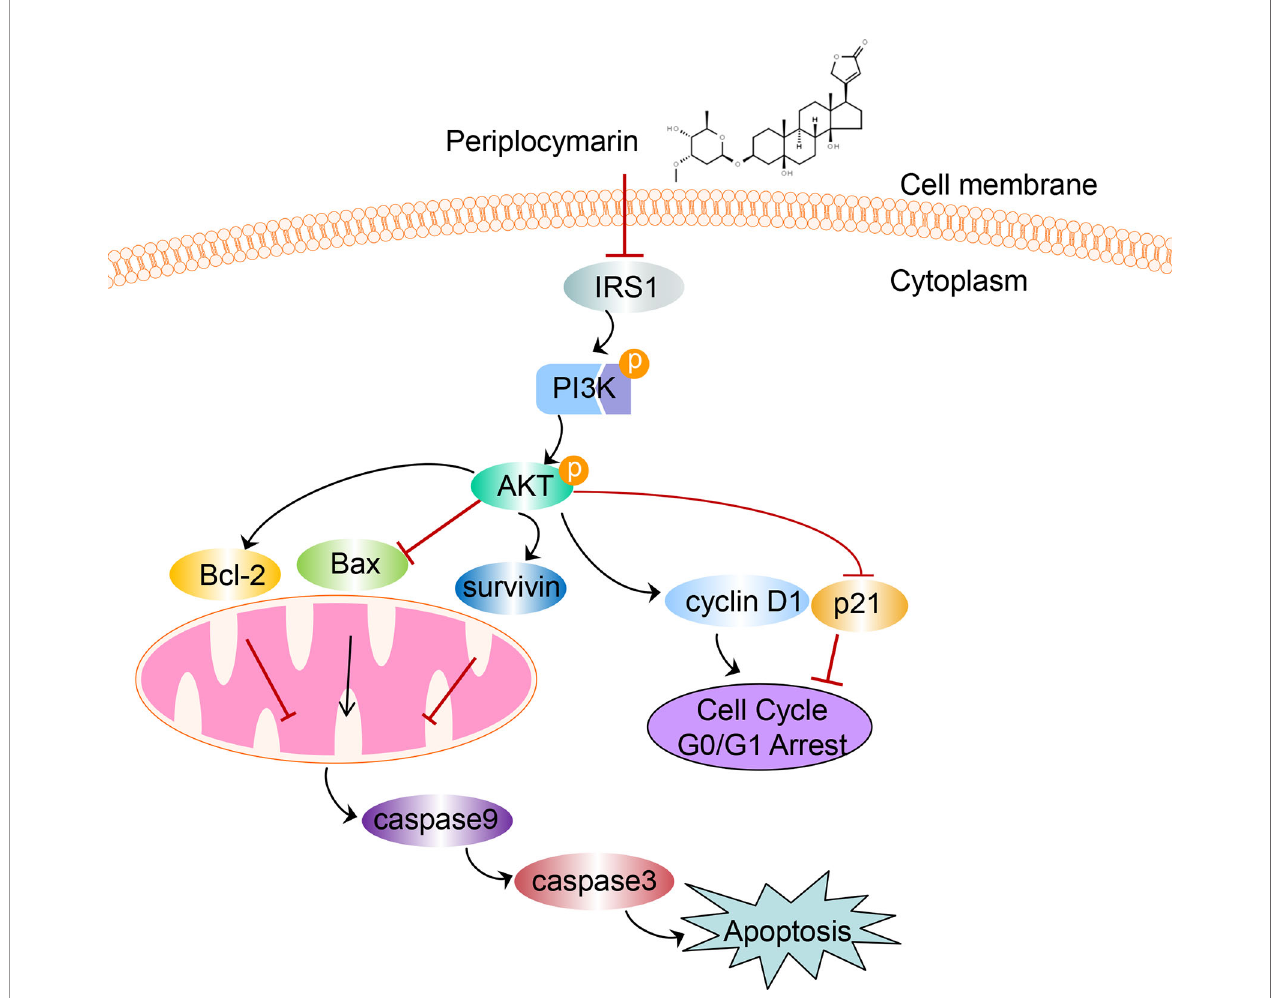
FIGURE 8 | The schematic diagram depicts the mechanism of PPM-induced apoptosis and cell cycle arrest via impairing PI3K/AKT signaling pathway in CRC cells. We supposed that PPM may inhibit the expression of IRS1, p-PI3K, and p-AKT and modulate the expression of Bcl-2 family, survivin, p21, and cyclin D1, which further promotes apoptosis and cell cycle arrest in G0/G1 phase of CRC